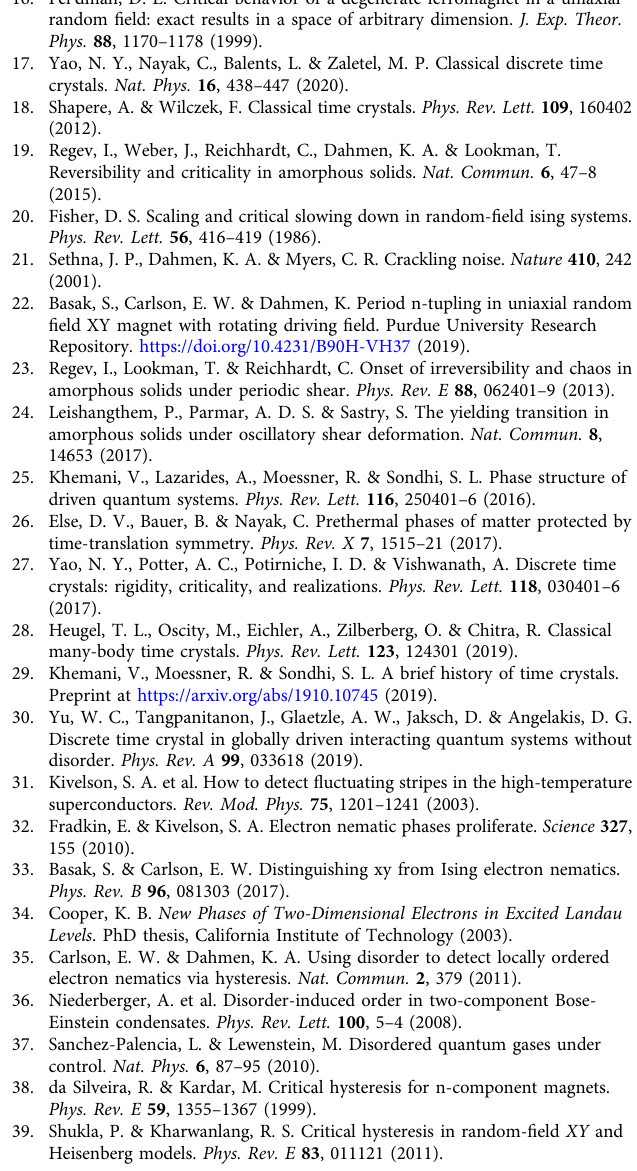
Table 2 Number of disorder con fi gurations used in Figs.